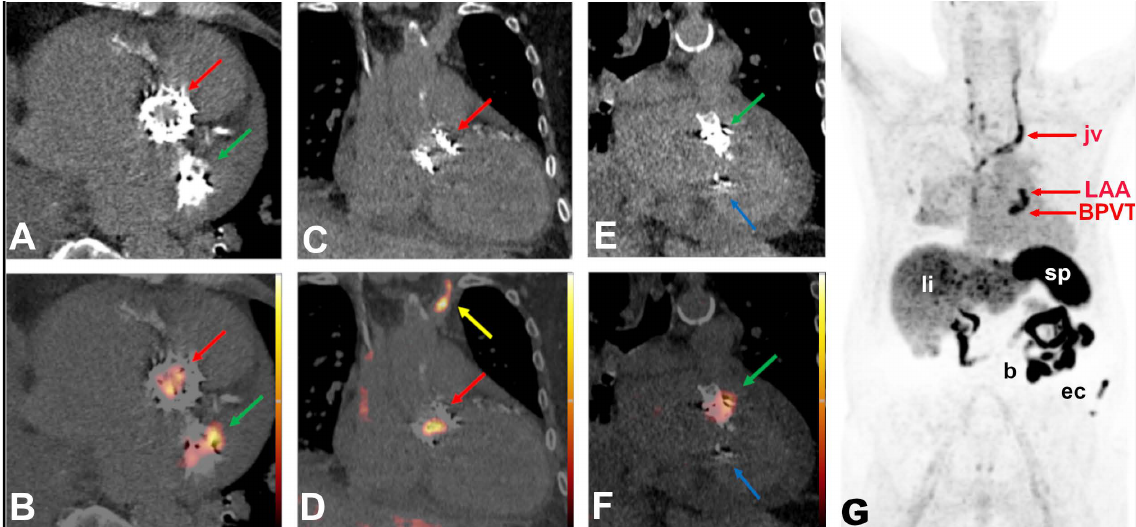
Figure 1. [ 18 F]GP1 PET/CT imaging findings of patient #1 with BPVT and thrombus in left atrial appendage (LAA) adherent to LAA occluder. ( A ) Axial view of unenhanced low-dose CT used for attenuation correction and anatomical landmarking with BPVT (red arrow) and thrombus in LAA (green arrow). ( B ) Axial view of corresponding fusion PET/CT images with [ 18 F]GP1, BPVT (red arrow), thrombus in LAA (green arrow). ( C ) Coronal view of unenhanced low-dose CT with BPVT (red arrow). ( D ) Coronal view of the corresponding fusion PET/CT images with [ 18 F]GP1, BPVT (SUVmax 7.1, red arrow) and thrombi in jugular vein (SUVmax 9.7, yellow arrow). ( E ) Parasagittal view of unenhanced low-dose CT with thrombus in LAA (green arrow). ( F ) Parasagittal view of corresponding fusion PET/CT image with [ 18 F]GP1 with LAA thrombus (SUVmax 6.8, green arrow). No tracer accumulation was seen at the MitraClip device (blue arrow). ( G ) Maximum intensity projection (MIP) of [ 18 F]GP1 PET showing physiologic tracer distribution within visceral organs and clearly visible tracer accumulation at the site of aortic valve replacement (BPVT). Additional tracer accumulation can be observed within the LAA as well as in the course of the left jugular vein (jv). Abbreviations: b—bowel, BPVT—bioprosthetic valve thrombosis, ec—external contamination, jv—jugular vein, LAA—left atrial appendage, li—liver, sp—spleen. Color bars representing SUVs from 0–5.12